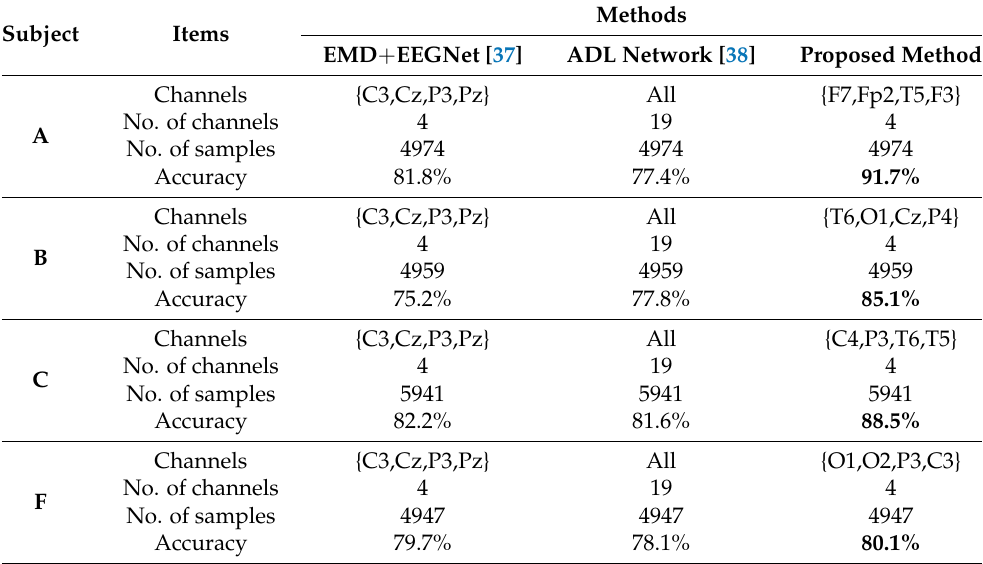
Table 12. Comparison with the state-of-the-art based on other channel selection